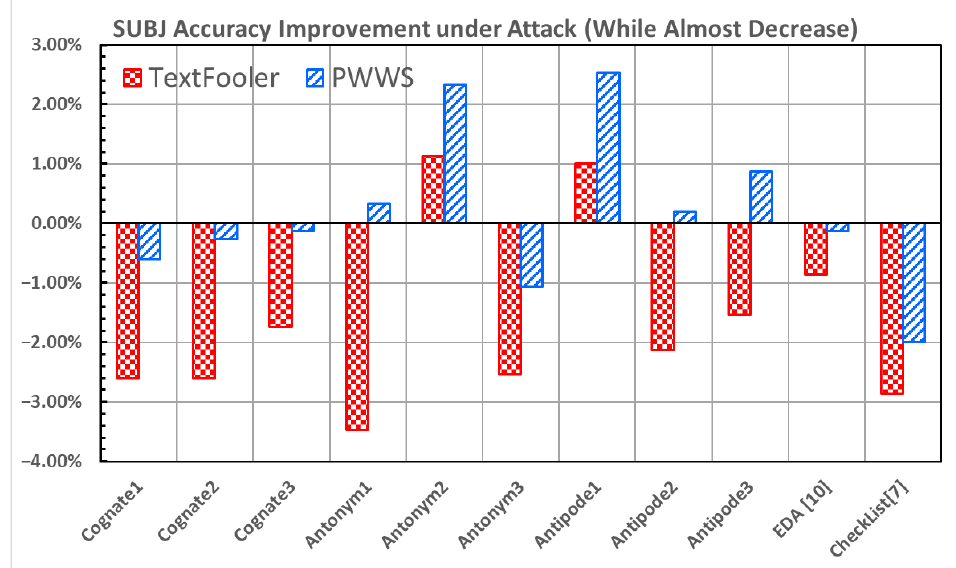
Figure 9. SUBJ Accuracy Improvement Under Attack.